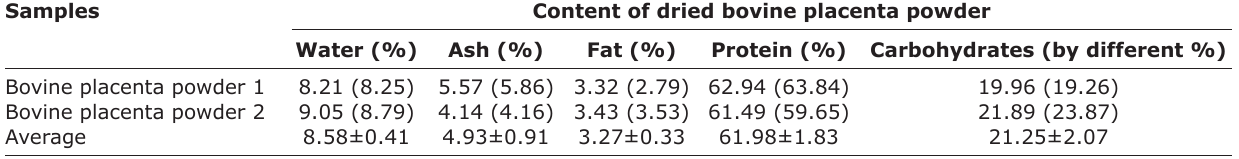
Table-1: Contents nutrient analysis of dried bovine placenta